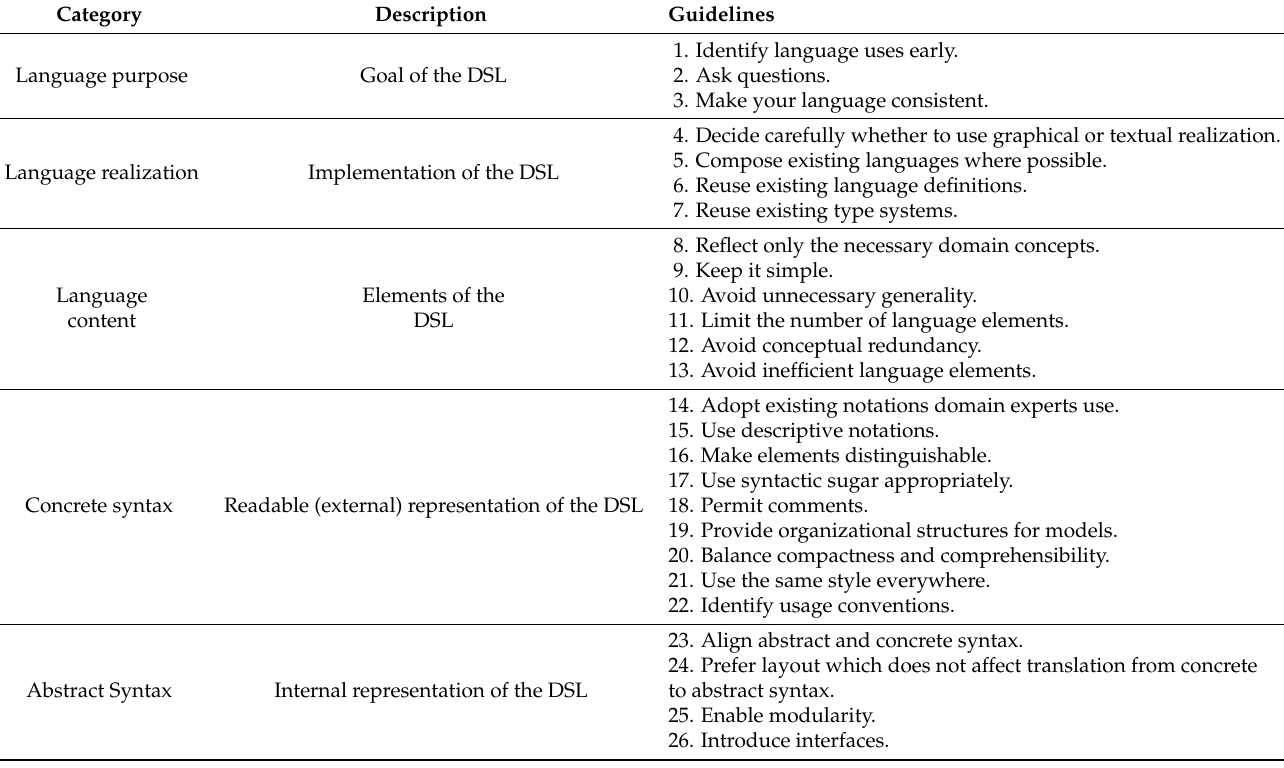
Table 2. Categories of DSL design guidelines proposed by Karsai et al.